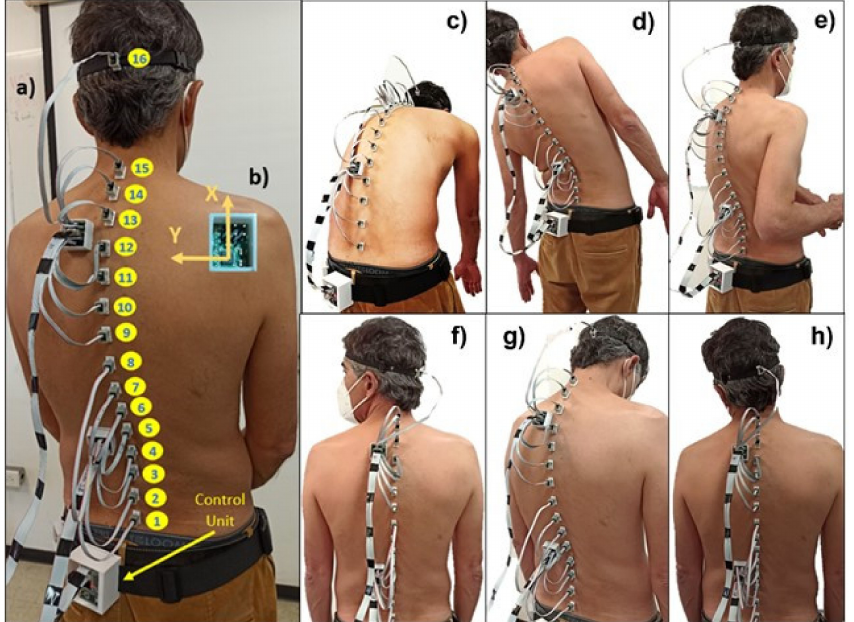
Figure 2. The embodiment of the system: ( a ) MIMUs over the patient’s spine; ( b ) frame reference of the sensors, with the z -axis out of the image. The movements considered in the experimental study: ( c ) anterior hip flexion; ( d ) trunk lateral flexions; ( e ) trunk axial rotation; ( f ) cervical axial rotation; ( g ) cervical flexion/extension; ( h ) cervical lateral